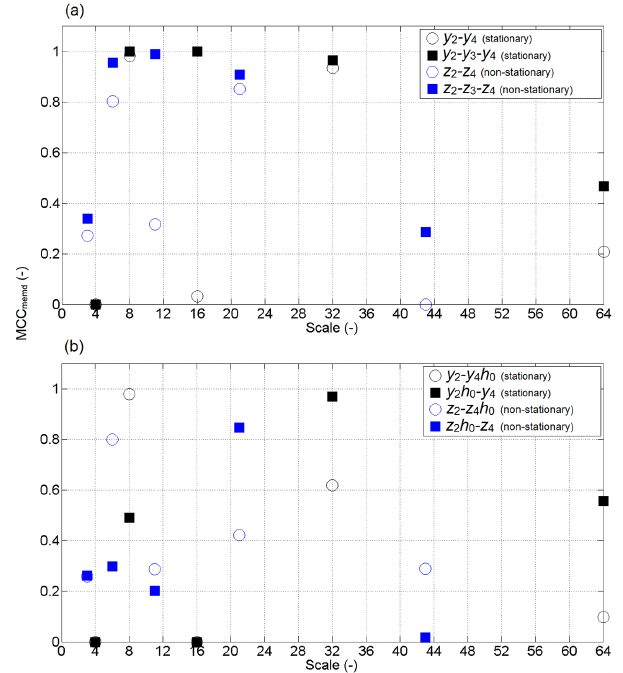
Figure 6. Multiple correlation coefficient between multivariate em- pirical mode decomposition (MCC memd ) of an artificial series ( y or z) and (a) two ( y 2 and y 4 ; or z 2 and z 4 ) or three ( y 2 , y 3 , and y 4 ; or z 2 , z 3 , and z 4 ) data series, and (b) two ( y 2 and y 4 ; or z 2 and z 4 ) data series when the second half of one data series is replaced by 0. The variables y 2 h 0 (or z 2 h 0 ) and y 4 h 0 (or z 4 h 0 ) refer to the new series of y 2 (or z 2 ) and y 4 (or z 4 ) in which the second half is replaced by